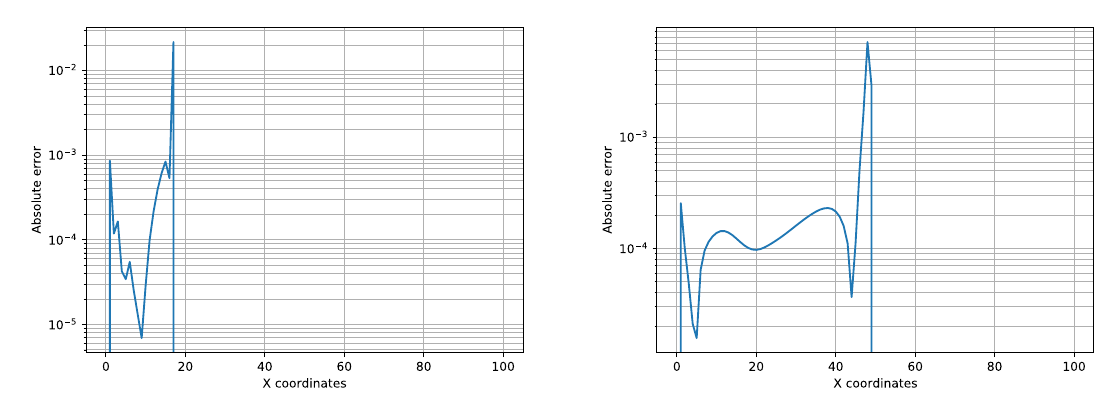
Figure 5. Absolute error for M = 4.5 (left) and M = 71 (right) for time step